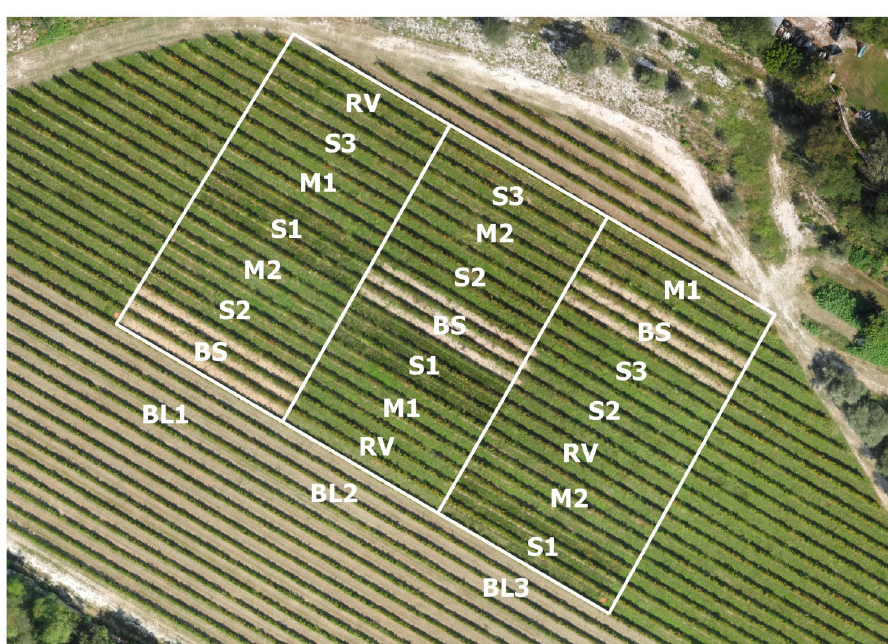
Fig 1. Plot arrangement for a field trial in a vineyard in Arqu à Petrarca (Padua, north-eastern Italy, N 45˚15’09, E 11˚42’09, 35 m a.s.l.) (image acquired by Tonon F. on September 2020). S1, S2, and S3 = grass blends, M1 and M2 = grass-legume mixtures, BS = bare soil, RV = resident vegetation, BL1-BL3 =